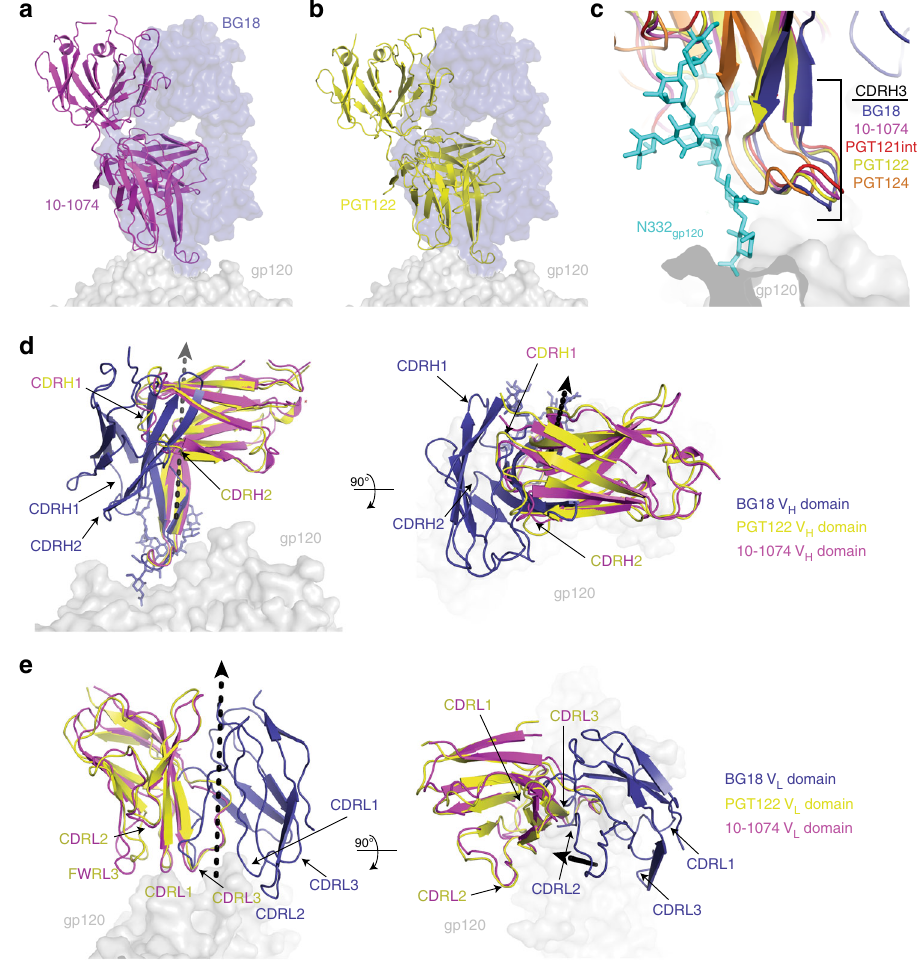
Fig. 3 Distinct orientation on HIV-1 Env of BG18 compared to other V3/N332 gp120 bNAbs. BG18 Fab (blue, surface) orientation on gp120 (gray, surface) overlaid with 10-1074 ( a , magenta; PDB 5T3Z (http://dx.doi.org10.2210/pdb5T3Z/pdb)) and PGT122 ( b , yellow; 5FYL (http://dx.doi.org10.2210/ pdb5T3Z/pdb)) and PGT122 ( b , yellow; 5FYL (http://dx.doi.org10.2210/pdb5FYL/pdb)) Fabs. c Overlay of CDRH3 loop of BG18 (blue), 10-1074 (magenta), PGT122 (yellow), PGT121 precursor (red; PDB 5CEZ (http://dx.doi.org10.2210/pdb5CEZ/pdb)), and PGT124 (orange; PDB 4R2G (http://dx.doi.org10.2210/pdb4R2G/pdb)) after alignment of bound gp120s (gray, surface) demonstrating a conserved structural motif recognizing the N332 gp120 glycan (cyan). d , e Comparison of V H -V L domains of PGT122 (yellow) and 10-1074 (magenta) with BG18 (blue). The V H -V L domain orientation of BG18 on Env trimer is related by a 78 ˚ rotation and 6.8 Å translation about the indicated axis (black dashed arrow) to the 10-1074 variable domains after alignment against gp120 in the BG18-Env and 10-1074-Env